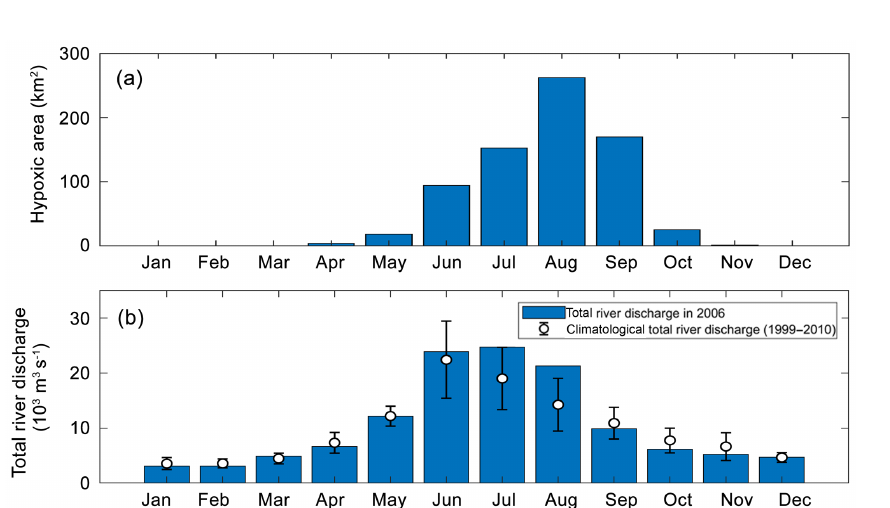
Figure 4. (a) Annual cycles of the model-simulated monthly hypoxic area in 2006 of the PRE, (b) annual cycle of the total river discharges in 2006 (blue bars) and during 1999–2010 (error bars represent a standard deviation around the climatological mean